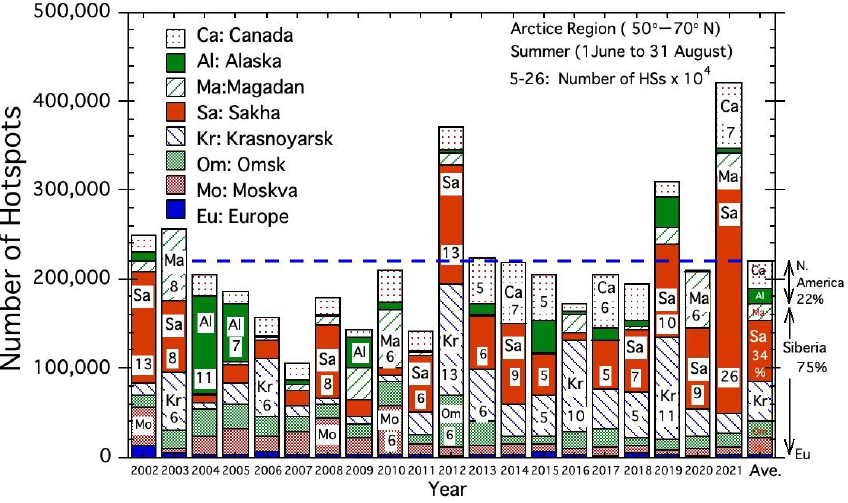
Figure 2. Recent fire history in the Arctic region from 2002 to 2021. The eight regions are: Europe (10° W – 30° E), Moskva (30° – 60° E), Omsk (60° – 80° E), Krasnoyarsk (80° – 110° E), Sakha (110° – 140° E), Magadan (140° – 190° E), Alaska (190° E – 30° W), and Canada (110° – 50° W). These eight areas are shown by the different color and pattern of the bar graph with the number of HSs (approximate number, ×10 4 ).